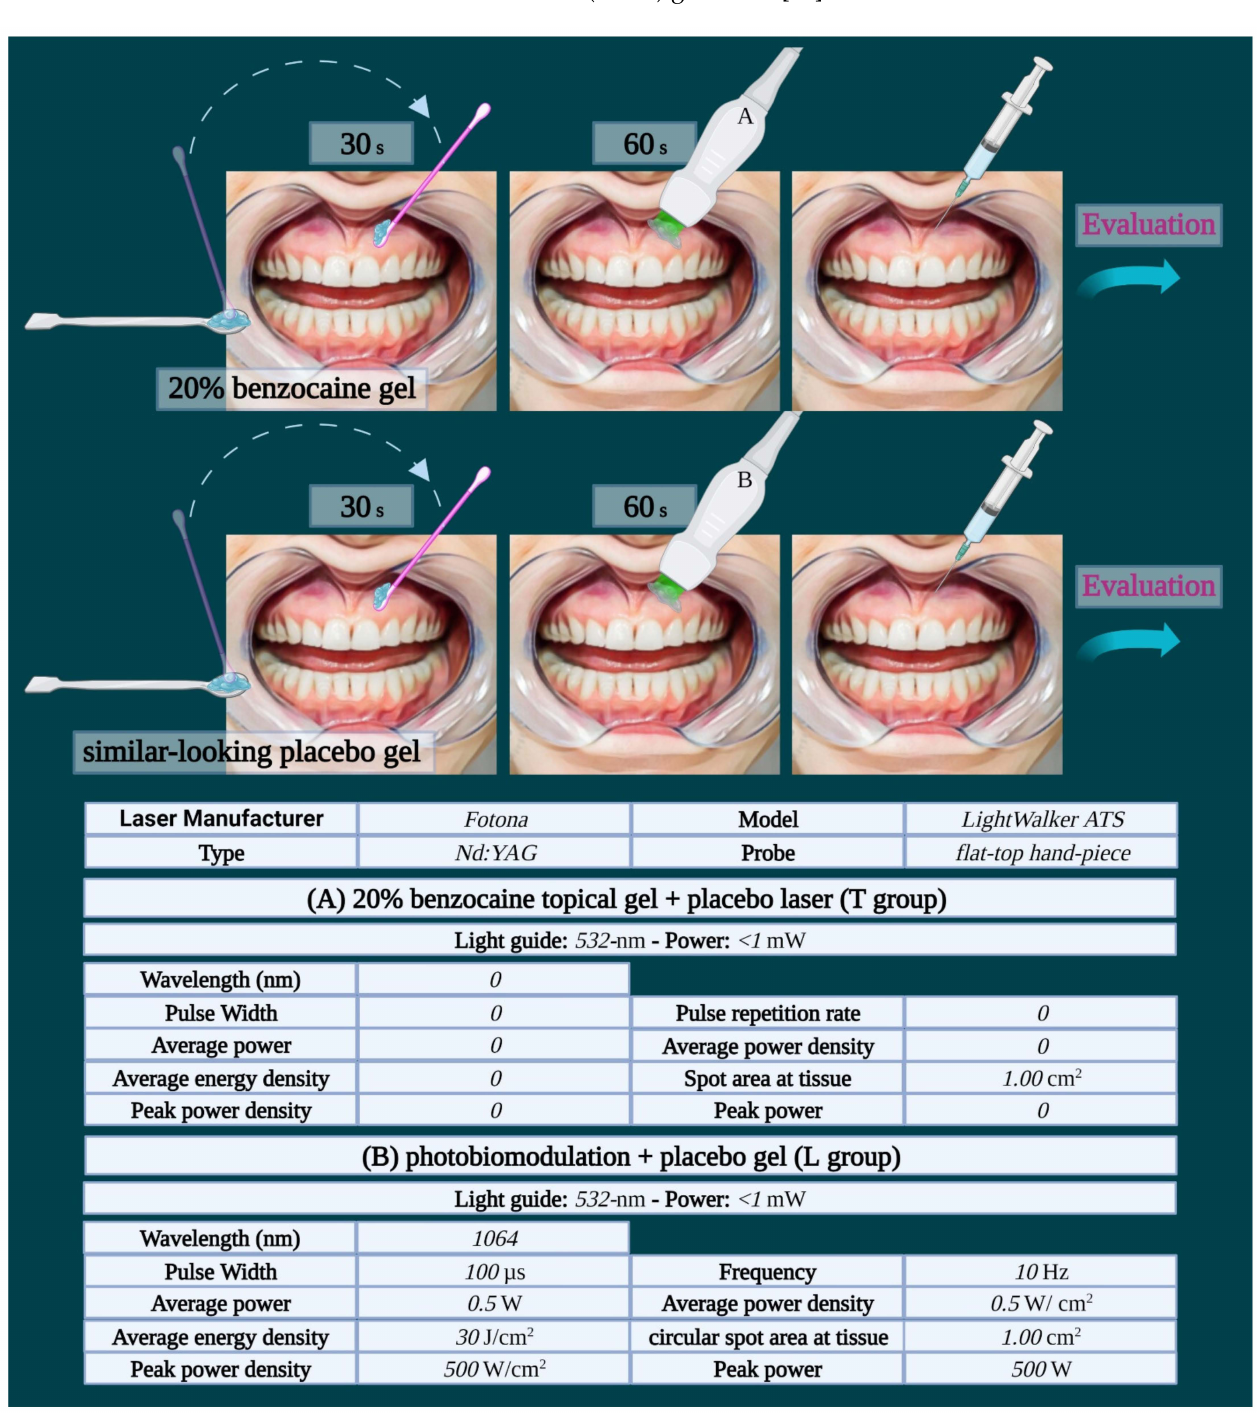
Figure 1. Illustration of the anesthetic procedures—Table of the adjustable and calculated laser